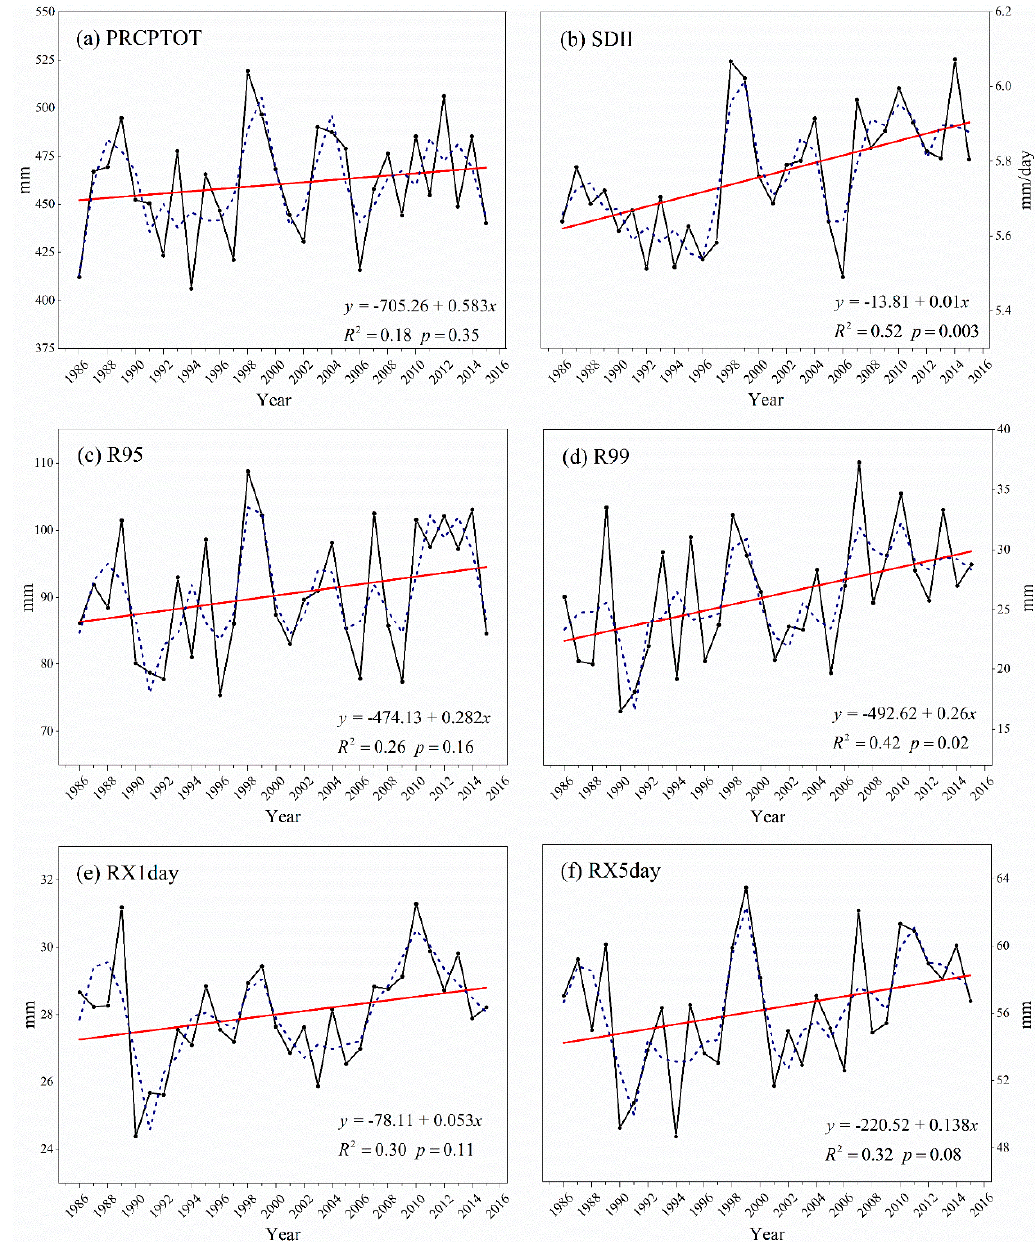
Figure 3. Interannual variation of precipitation across the Tibetan Plateau from 1986–2015. Graphs represent ( a ) PRCPTOT, ( b ) SDII, ( c ) R95, ( d ) R99, ( e ) RX1day, and (f) RX5day. The black solid line is interannual variation, the red solid line is the linear trend, and the blue dotted line is the five-year smoothing